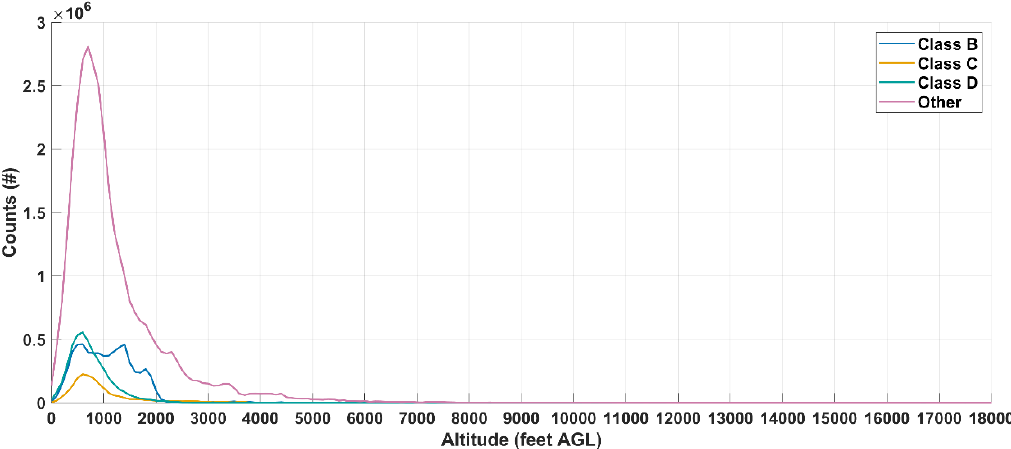
Figure 4. Altitude and airspace distributions for rotorcraft below 18,000